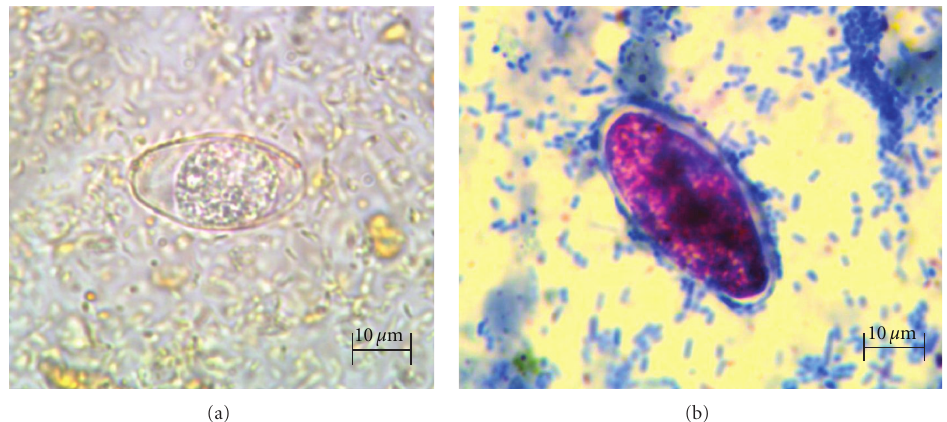
Figure 1: (a) Isospora belli , saline mount. (b) Isospora belli . Modified acid-fast stain.